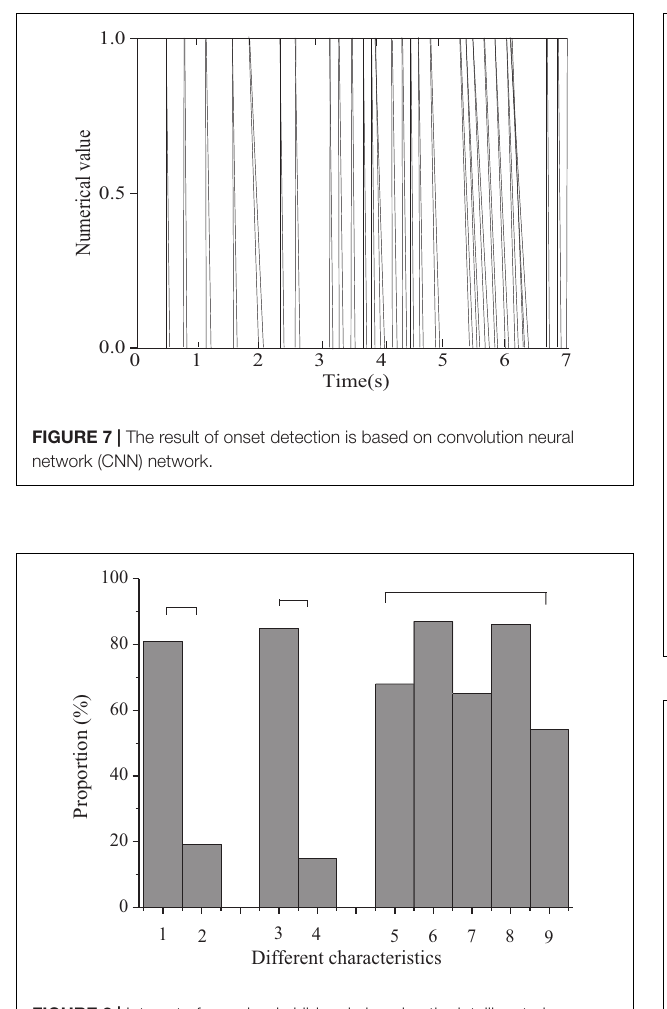
FIGURE 8 | Interest of preschool children in learning the intelligent piano (“ ” represents the same dimensions; 1, children like intelligent music scores; 2, children like paper music scores; 3, children like piano lessons with games; 4, children do not like piano lessons with games; 5, children like reading music score; 6, children like playing the piano; 7, children like music